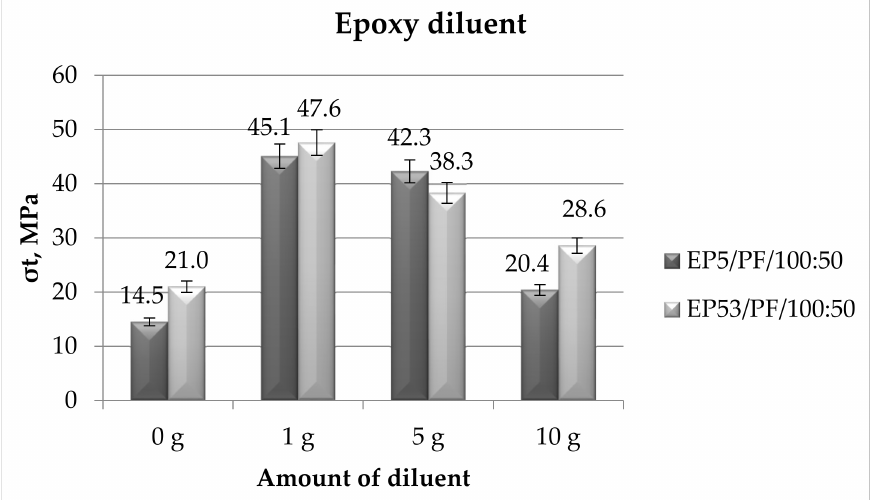
Figure 20. Tensile strength calculated for Epidian 5 and Epidian 53 epoxy compounds as a function of the amount of epoxy